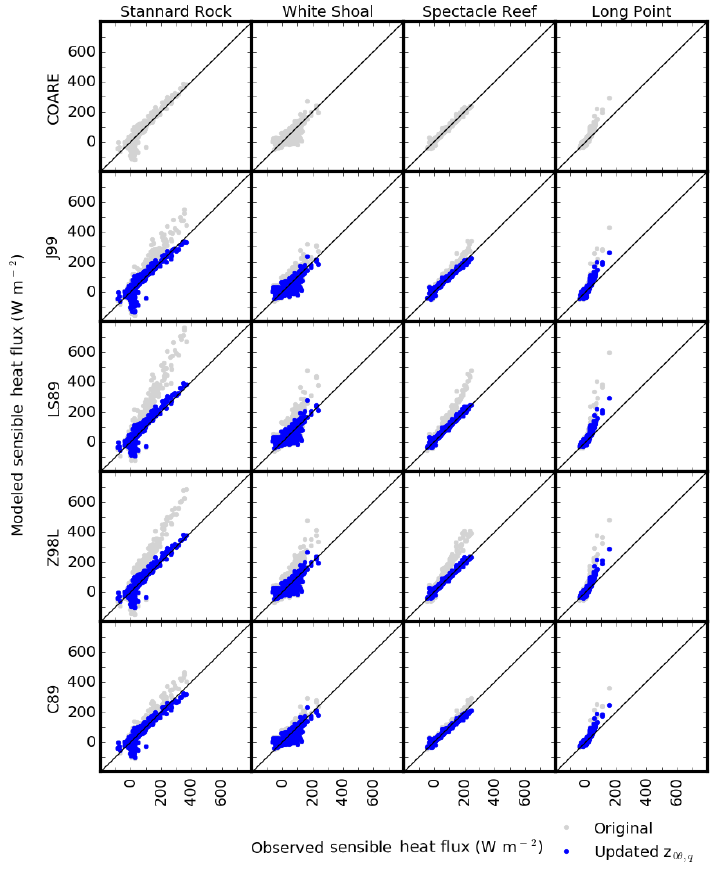
Figure 8. Scatter plots of latent heat flux ( λE ) comparing the observed ( x axis) and the simulated ( y axis) daily mean fluxes. Each row shows comparisons with a specific algorithm at the four stations, while each column shows comparisons with the five algorithms at a specific station. Gray and blue dots indicate the results with the original and updated z 0 θ,q formulae,